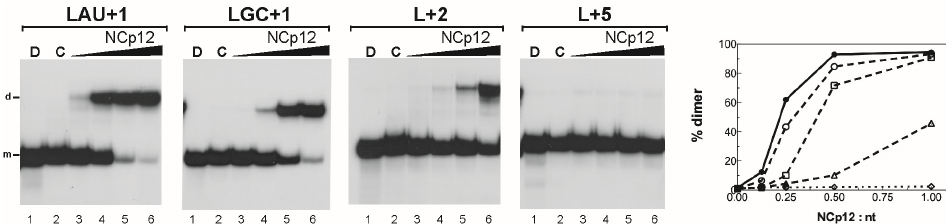
Figure 7. Influence of stem C extensions on NCp12-mediated L3 RNA dimerization. The 5 ′ -end- labeled L RNAs in the absence (lanes C) or the presence of NCp12 (lanes 3–6) were incubated at 37 °C as described in Materials and Methods. After phenol–chloroform extraction, the samples were analyzed by electrophoresis on 12% polyacrylamide gels at 25 °C in the TBE buffer. Heat-denatured L RNAs (lanes D) were used to identify the bands corresponding to monomeric L RNAs. Lanes 3–6, protein to nucleotide molar ratios were 1:8, 1:4, 1:2, and 1:1. The monomeric and dimeric forms of L RNAs are indicated by m and d, respectively. The graph was derived from the gels shown in this figure and Figure 4. Filled circles, Lwt RNA; open circles, LAU+1 RNA; open squares, LGC+1 RNA; open triangles, L+2 RNA; open diamonds, L+5 RNA.